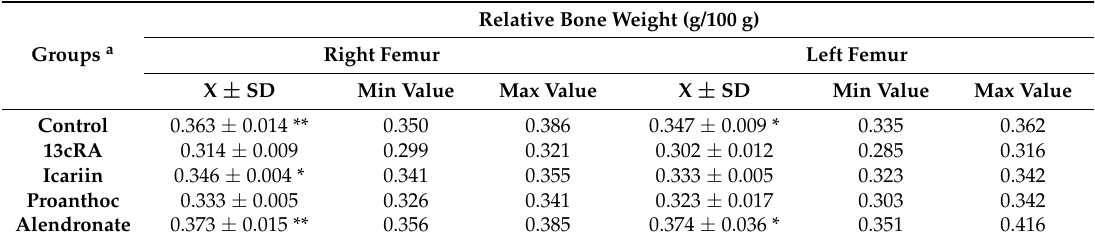
Table 3. Effect of icariin, proanthocyanidins and alendronate on relative bone weight in rats with retinoic acid-induced bone loss.